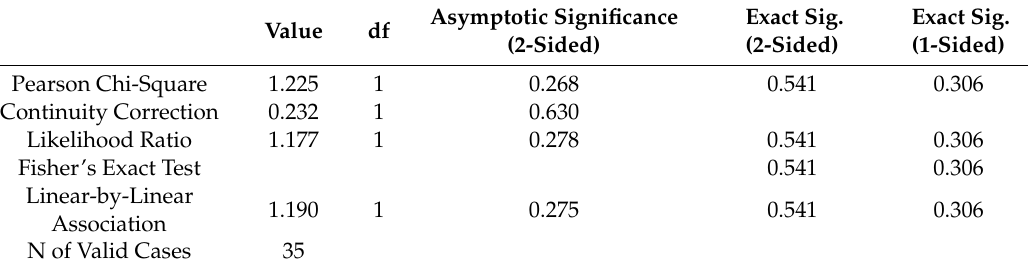
Table 4. The chi-square test for the availability of modifications.